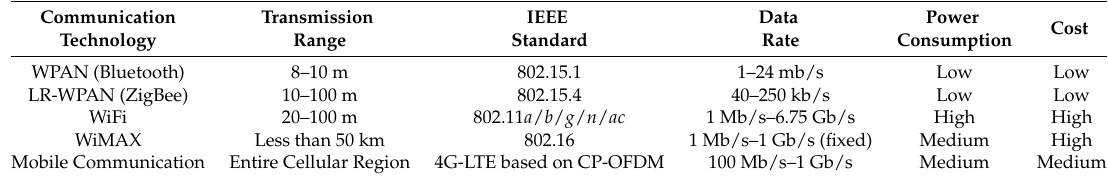
Table 5. A comparison of existing IoT communication technologies for EC in Oil and Gas extractions.